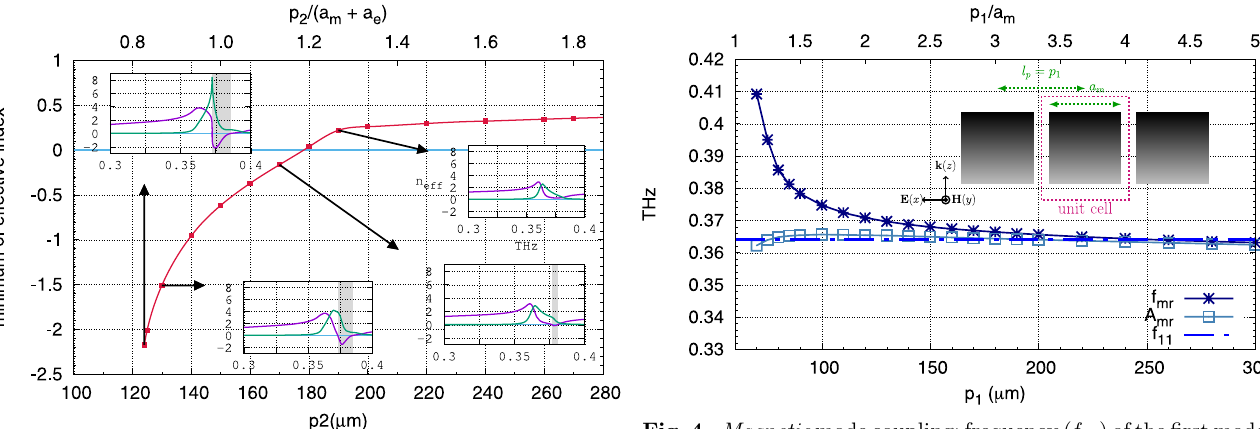
Fig. 4. Magnetic mode coupling: frequency ( f mr ) of the fi rst mode of Mie resonances and of the maximum of absorption ( A mr ) as a function of the distance p 1 between two resonators. The unit cell only comprises the magnetic block. The side length of the resonator is a m =60 m m. The dashed line denotes the resonance frequency ( f 11 ) of the mode of resonances of the individual resonator.